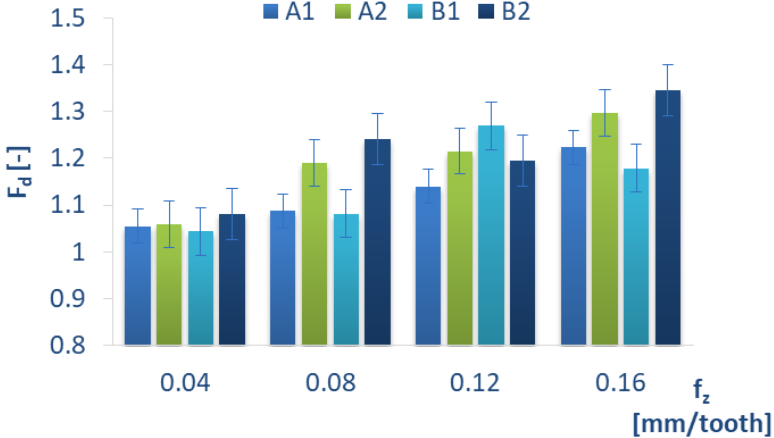
Figure 18. Delamination factor 𝐹 𝑑 for different feed per tooth f z and constant cutting speed v c = 182 m/min for different GFRP materials.